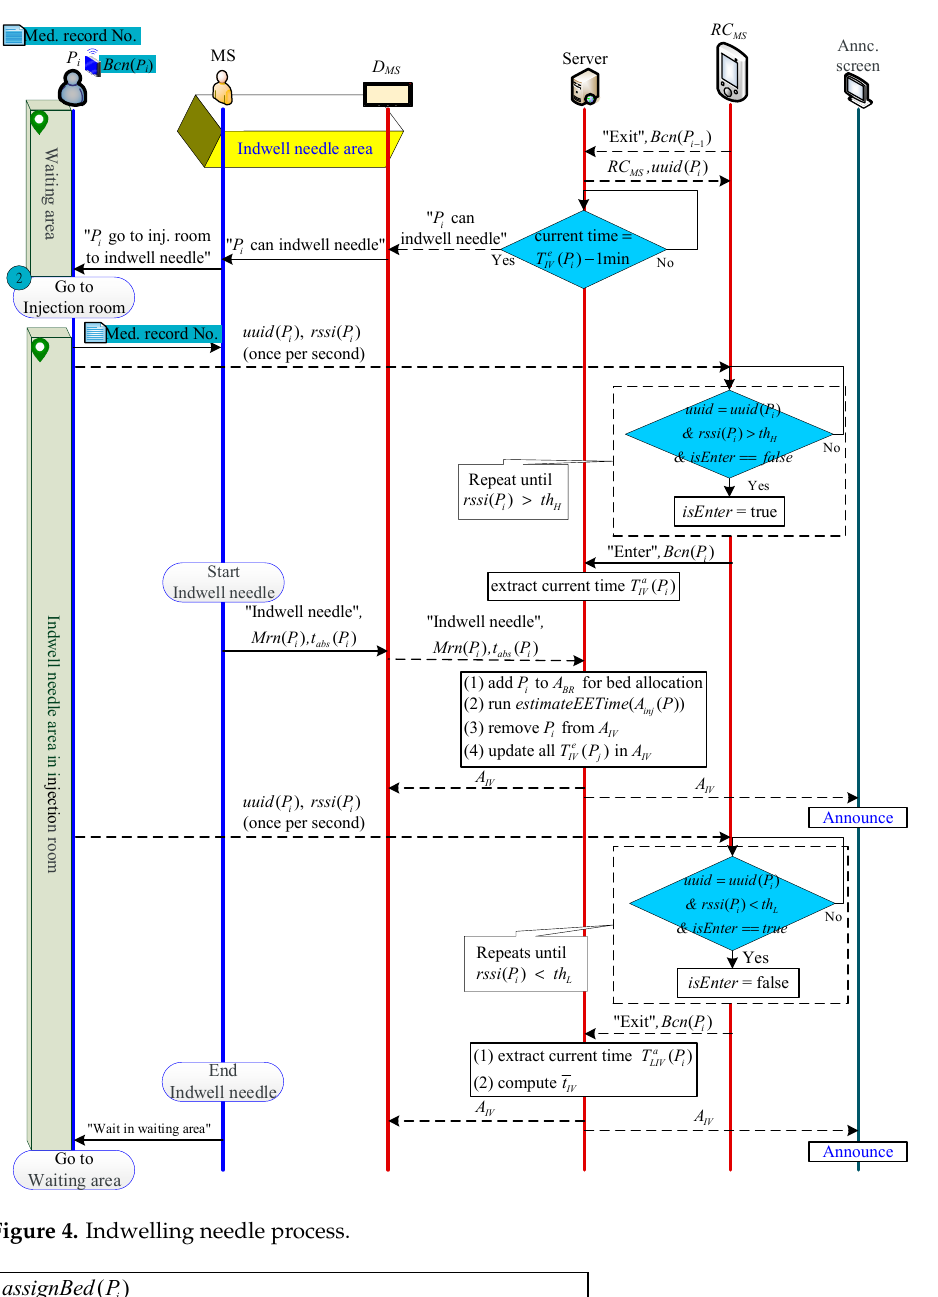
Figure 4. Indwelling needle process.